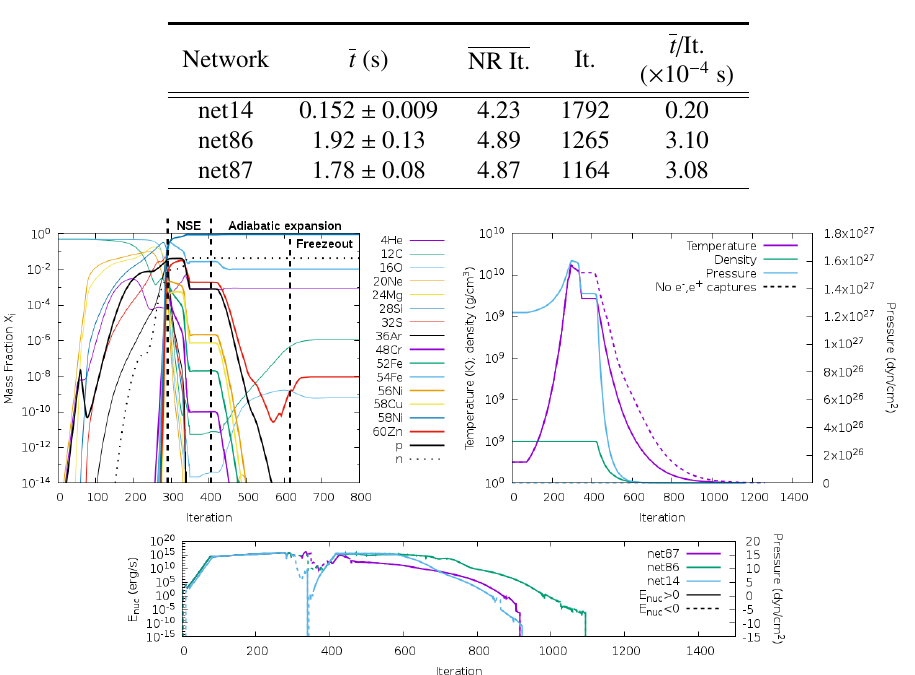
Figure 2. Evolution of the most relevant quantities in the 12 C + 16 O test. Top-left: nuclear abundances for net87 ; top-right: temperature, density, and pressure for net87 and net86 ; bottom: nuclear energy generation rate for net87, net86 and net14